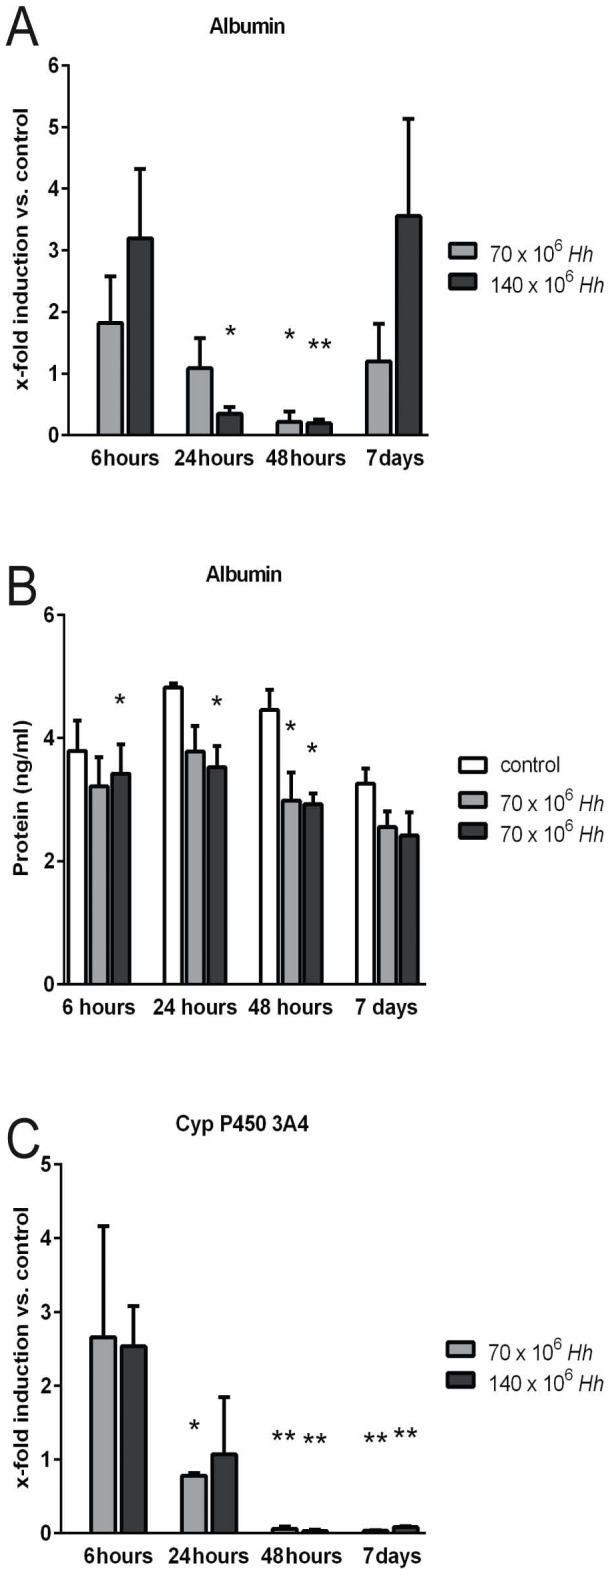

H. hepaticus impairs physiological cell functions of primary human hepatocytes (PHH).PHH were co-cultured with H. hepaticus at a MOI of 50 (70×106 Hh) or 100 (140×106 Hh) bacteria per hepatocyte (n = 3). (A) Albumin mRNA expression in PHH decreased after an initial, transient increase, with lowest levels at 48 hours of co-cultivation with H. hepaticus at a MOI of 100 bacteria per hepatocyte returning to unchanged or even higher levels on day 7. (B) The downregulation in albumin gene expression in PHH resulted in a slight, but statistically significant reduction of albumin concentration in the supernatant of co-cultured hepatocytes 6, 24 and 48 hours after infection as measured by ELISA. (C) Real-time RT PCR of hepatocytes revealed significantly decreased mRNA expression of cytochrome P450 3A4 24, 48 hours and 7 days after infection. Albumin and CYP 3A4 mRNA is expressed as the fold induction compared to untreated control culture from the same hepatocyte donor for each time point. (n = 3) * = p<0.05 and ** = p<0.005 versus control.